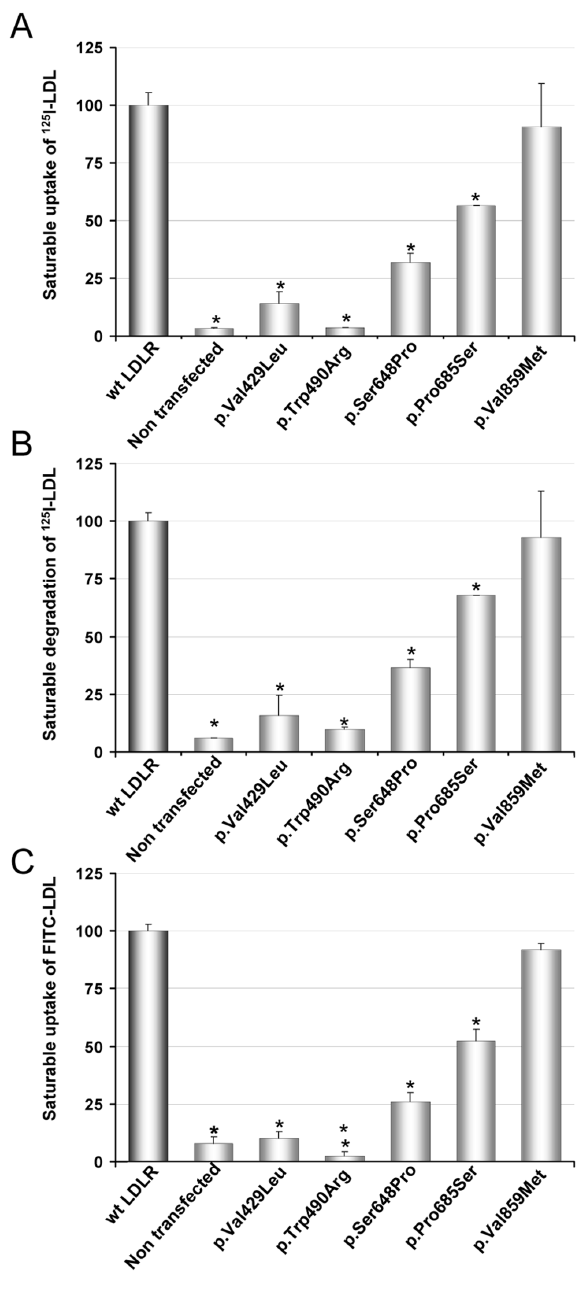
Figure 3. Uptake and degradation of labeled-LDL in CHO- ldlA7 transfected cells with wt or different LDLR variants. (A) Uptake of 125 I-LDL, (B) degradation of 125 I-LDL and, (C) uptake of FITC-LDL. For analysis of 125 I-LDL uptake (binding plus internalization) and degrada- tion, CHO- ldlA7 transfected cells expressing wt LDLR were incubated for 4 h at 37 u C with 20 m g/mL of 125 I-LDL as indicated. Subsequently, cells were assayed for cell associated radioactivity (uptake) and degradation of the protein component of LDL. Values were corrected for non- saturable association or degradation determined in the presence of an excess of unlabeled LDL (1 mg/mL). For analysis of FITC-LDL uptake, CHO- ldlA7 transfected cells expressing wt LDLR were incubated for 4 h at 37 u C with 20 m g/mL of FITC-LDL as indicated. 10,000 cells were acquired in a Facscalibur and values of LDL uptake were calculated as described in Material and Methods. The values represent the mean of triplicate determinations (n=3); error bars represent 6 SD. *p , 0.001 compared to LDLR wt using a Student’s